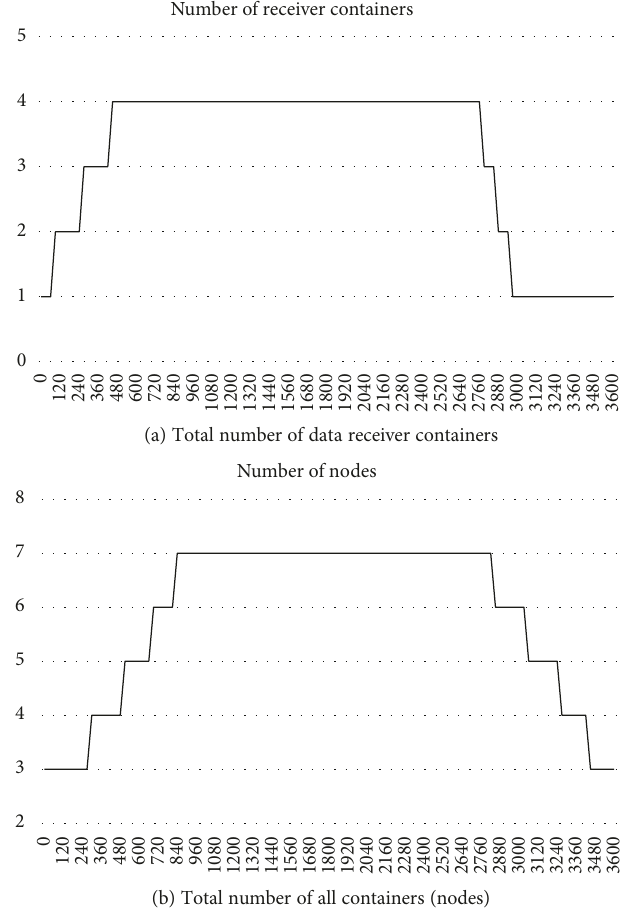
Figure 14: Number of